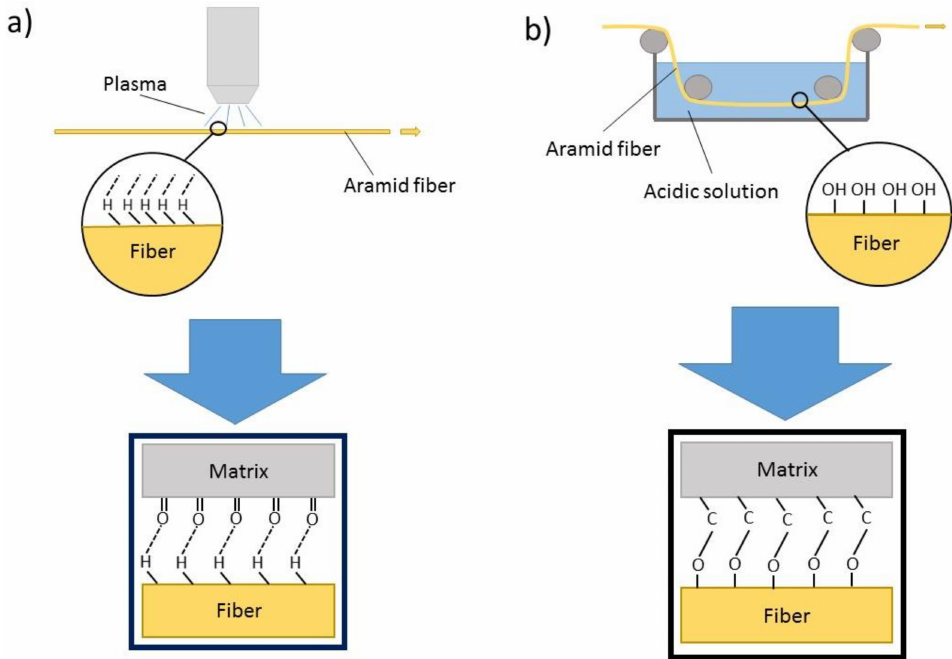
Figure 2. Schematic presentation of ( a ) physical and ( b ) chemical adhesion between fiber and